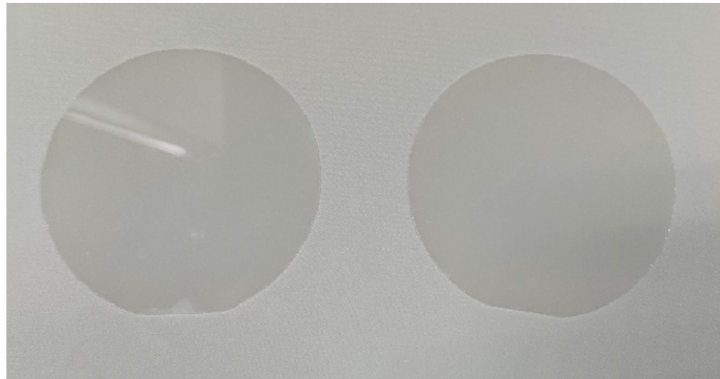
Figure 2. Lithium niobate polished sheet with a diameter of 3